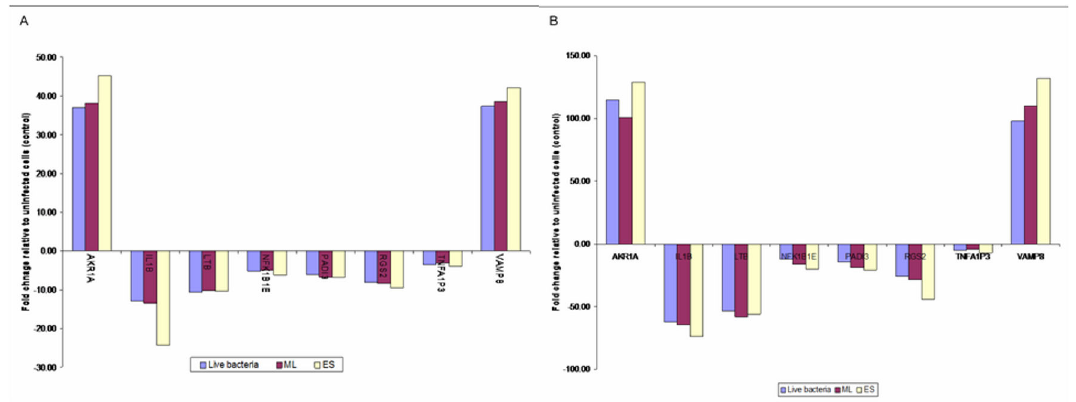
Figure 6. The relative relation between (A) microarray and (B) qRT-PCR assay. doi: